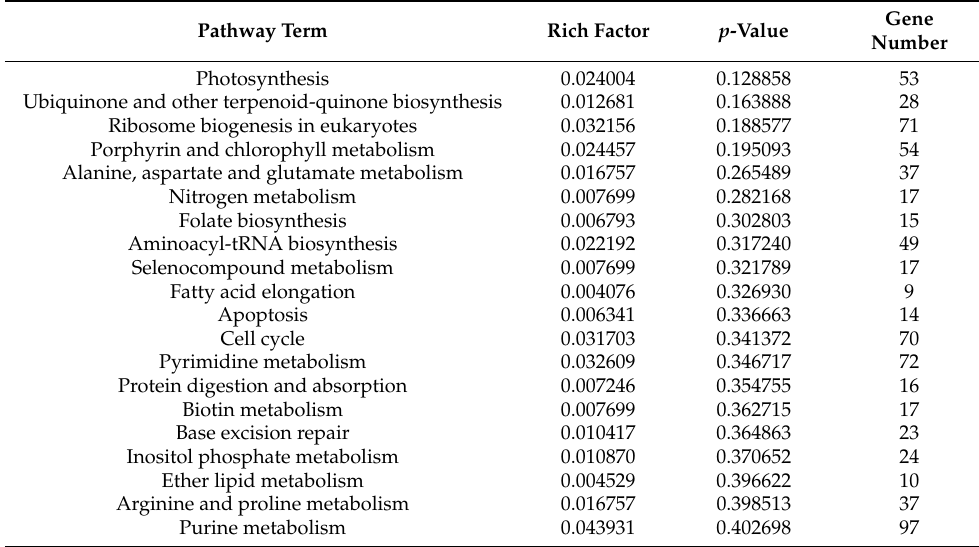
Table 4. The upregulated pathways of differentially expressed genes significantly enriched in KEGG in the 36 g/L CaCl 2 group compared with the 0.036 g/L group.